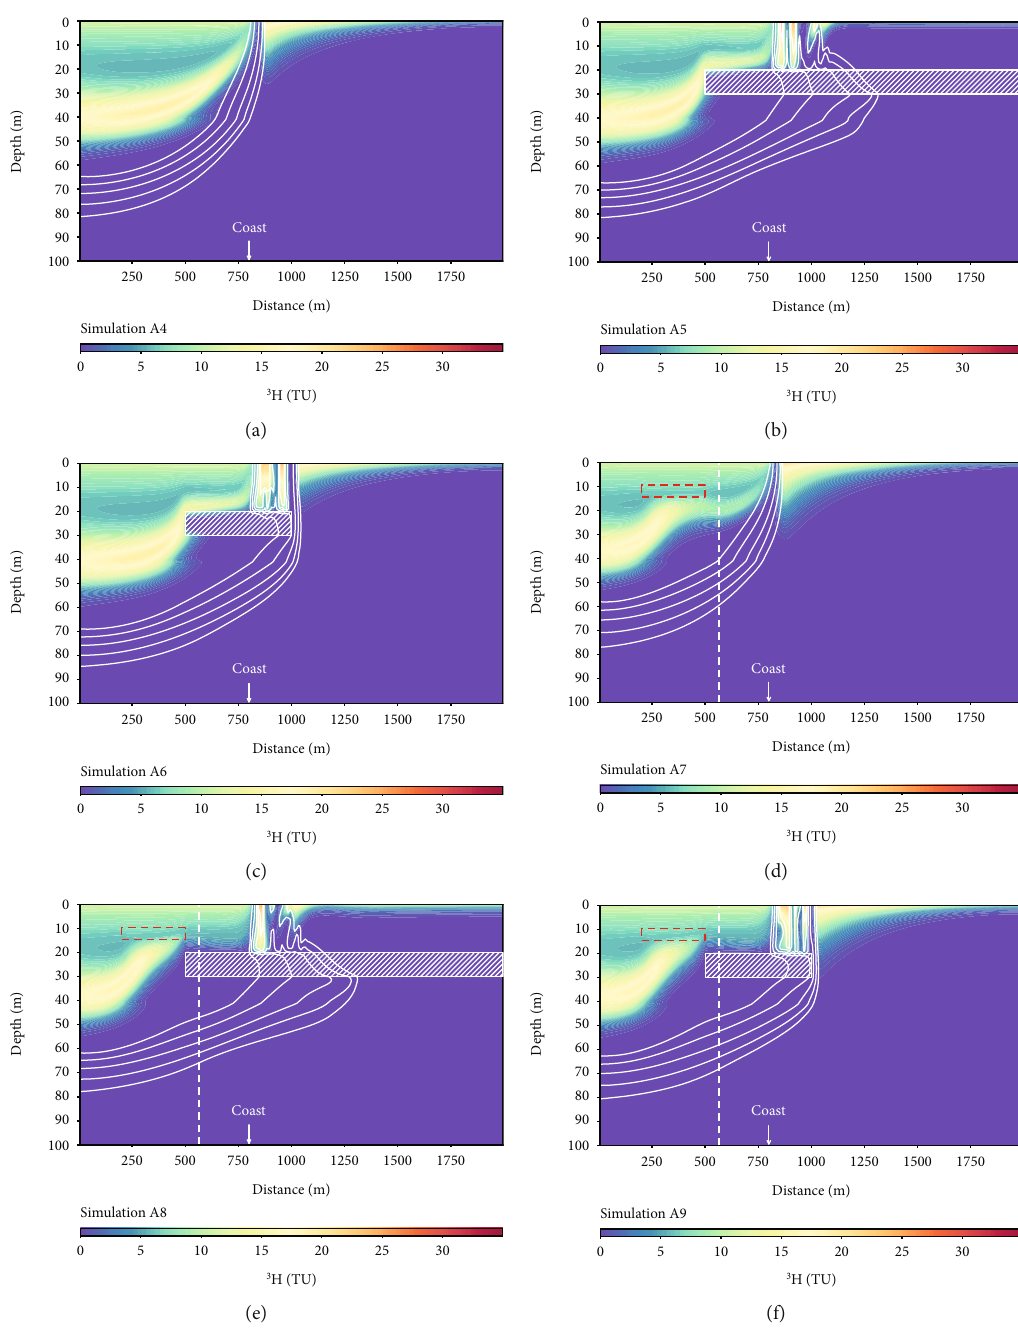
Figure 10: Contour plots of the simulated 3 H concentration activities (shaded colours) and Cl concentrations (white lines) at the end of the simulation period (31 December 2013). The fi ve white lines represent Cl concentrations equal to 2.5%, 16%, 50%, 84%, and 97.5% of the seawater chloride concentration (17g/L). Results are shown for simulations (a) A4, (b) A5, (c) A6, (e) A7, (f) A8, and (g) A9. The location of the clay layer is indicated by the hatched white rectangle. The open red rectangle in (d) – (f) encloses the cells with groundwater abstraction, and the dashed white line indicates the projected location of observation well